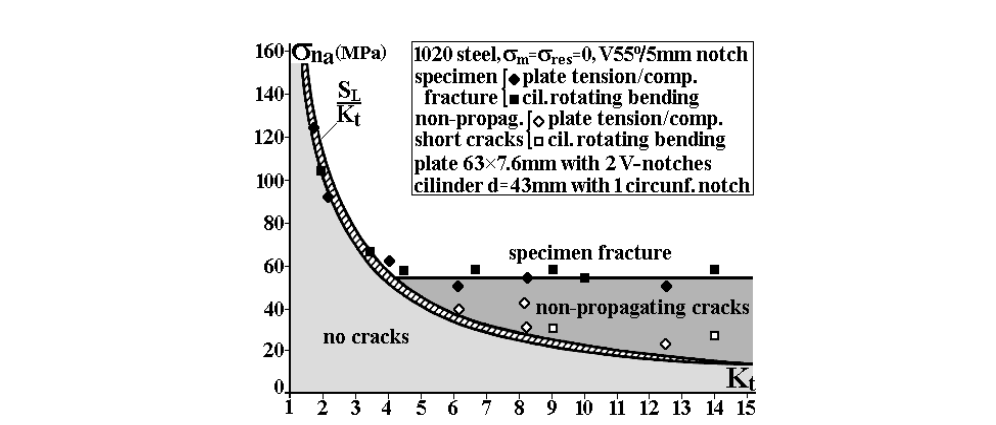
/K <  < S /K [2, 7]. L t n L f